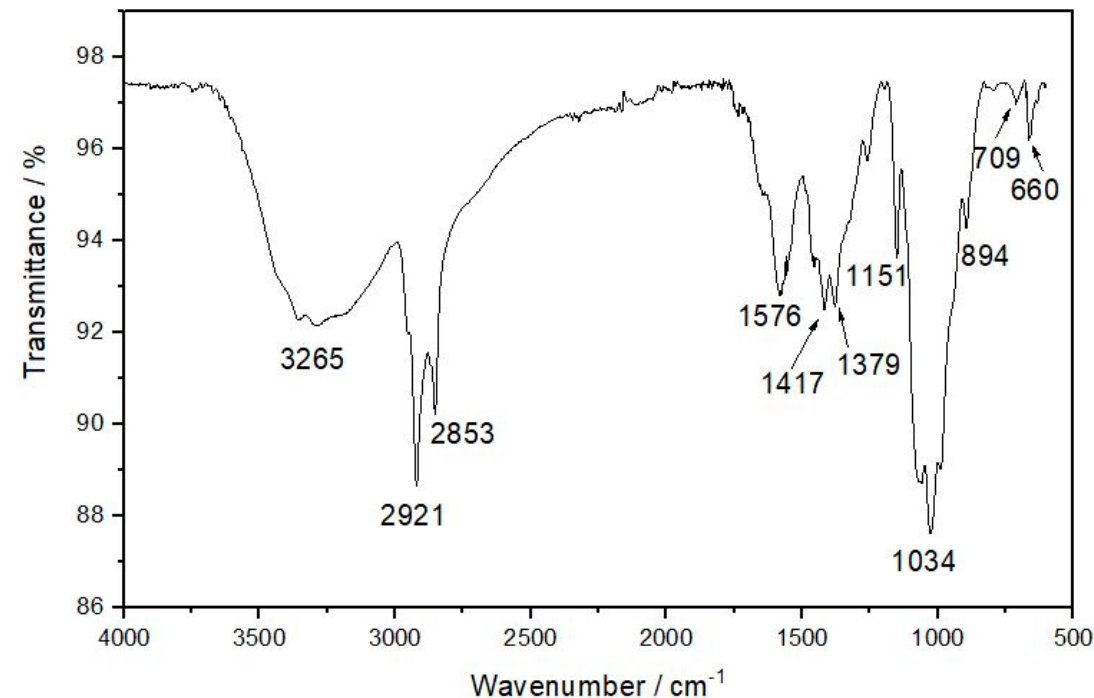
Figure A5. Infrared Spectrum of formulation.